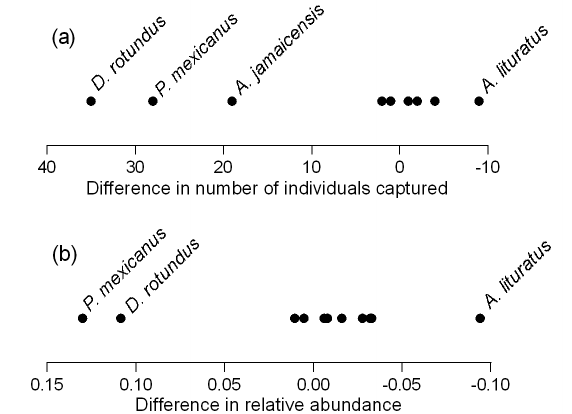
Figure 4. Differences in number of captures and relative abundance between 2016 and 2017 of captured species in Chamela. Only names of species with the greatest changes are included. Some of the dots in the cluster of points around zero represent multiple species.